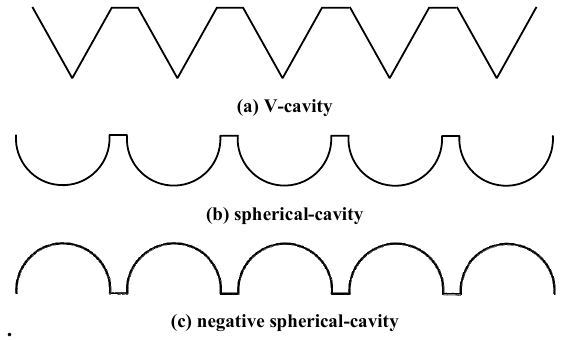
Figure 12. Modeled surfaces with different spherical shape hypotheses.